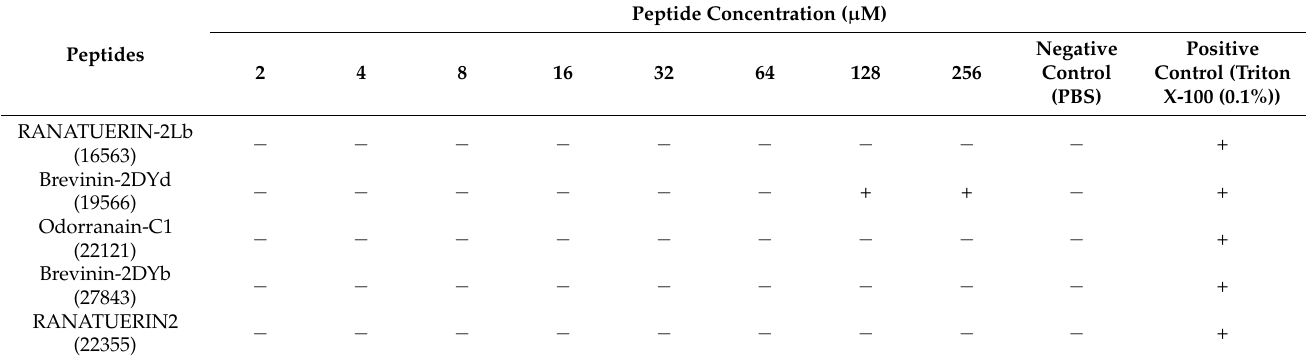
Table 7. Hemolytic effect of 5 peptides on 2% sheep